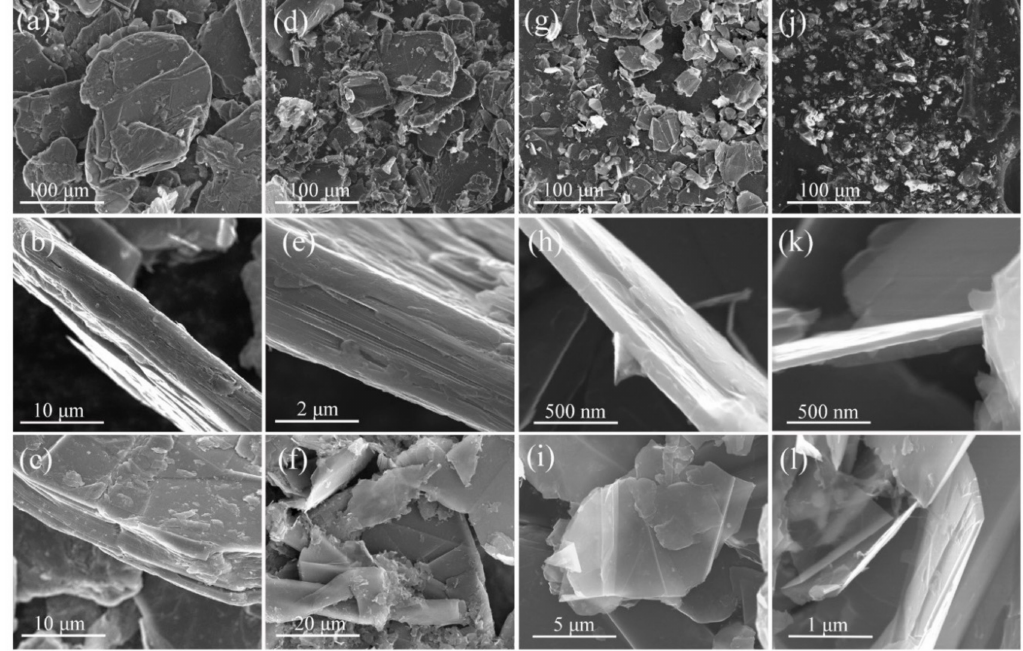
Figure 3. Size and morphology of ( a – c ) FG and products with 5 wt.% FG exfoliated at di ff erent times with a TRM ( d – f ): 1, ( g – i ): 8, and ( j – l ): 16